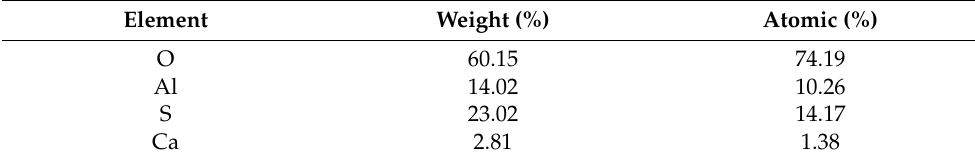
Figure 15. Location of microvoids in the sheared edge. (A represents the microvoid generated from the inclusion; B represents the microvoids formed at the phase interfaces; the green lines represent the phase interfaces.) Table 5. Elements and contents of inclusion.